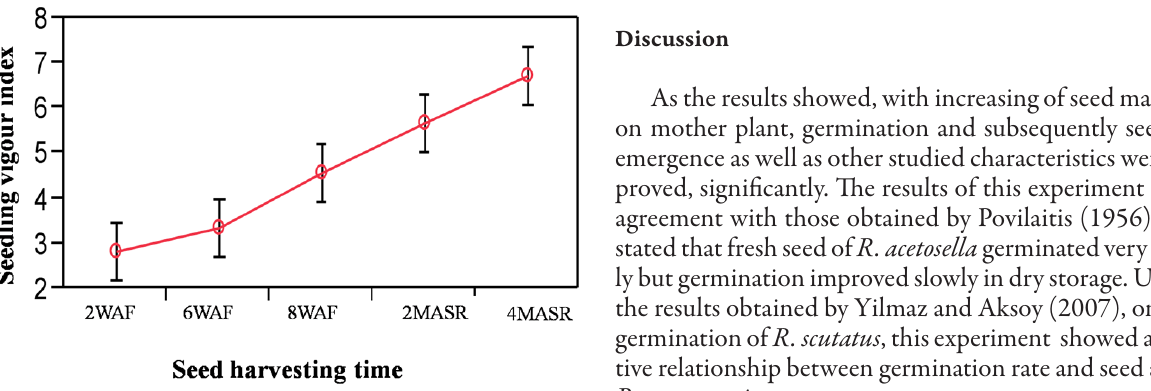
Fig. 3. Effect of different seed harvesting times on mean seedling vigour index in R. turcomanicus Czerep.